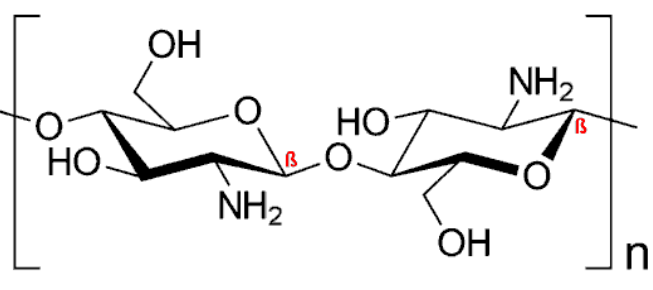
Figure 5. Chemical structure of chitosan (CS).